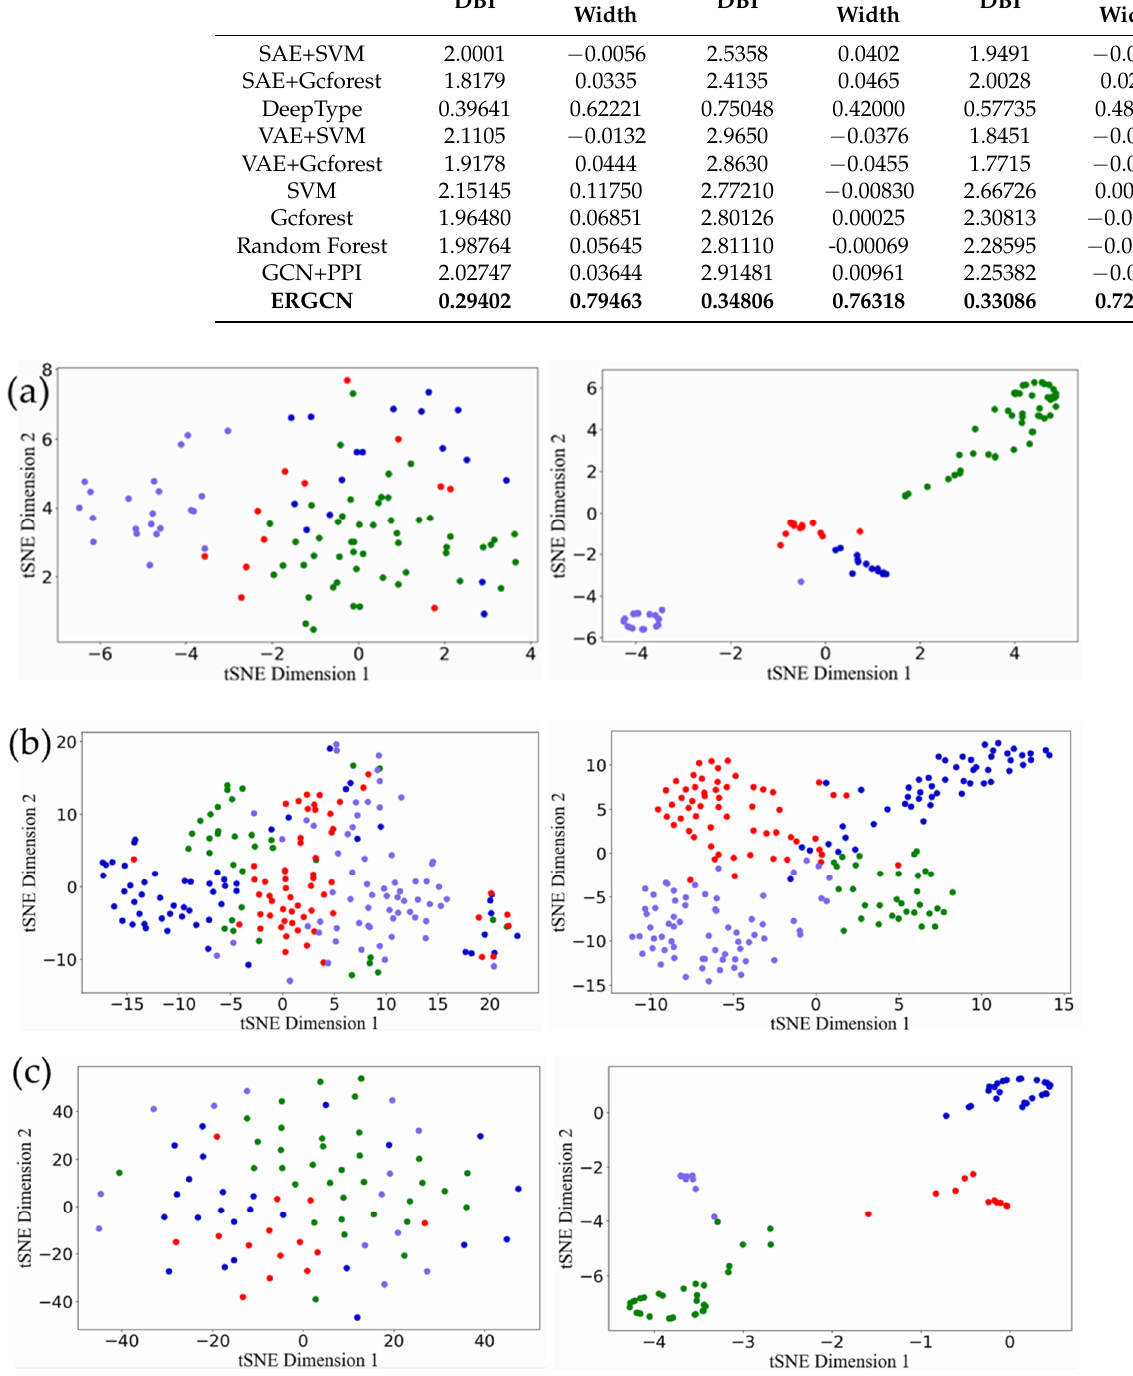
Figure 3. Visualization results of t-SNE. ( a ) The visualization result of BRCA. The first picture is the result of the original feature, and the second picture is the result of the latent features learned by ERGCN. ( b ) The visualization result of the GBM. The first picture is the result of the original feature. The second is the result of latent features learned by ERGCN. ( c ) The visualization result of LUNG, the first picture is the result of the original feature, and the second is the result of the latent feature learned by ERGCN.